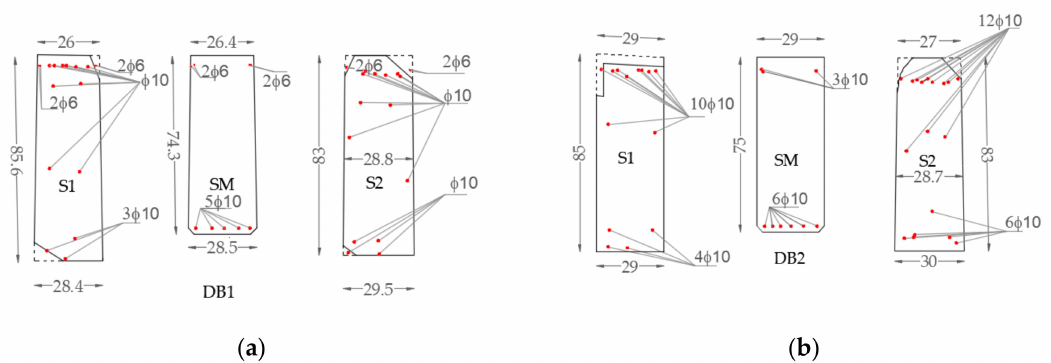
Figure 2. Beams DB1 ( a ) and DB2 ( b ); concrete geometries and steel reinforcement configuration for the sections at the beam ends (S1, S2) and at the beam midspan (SM); rebar diameter [mm]; concrete geometries